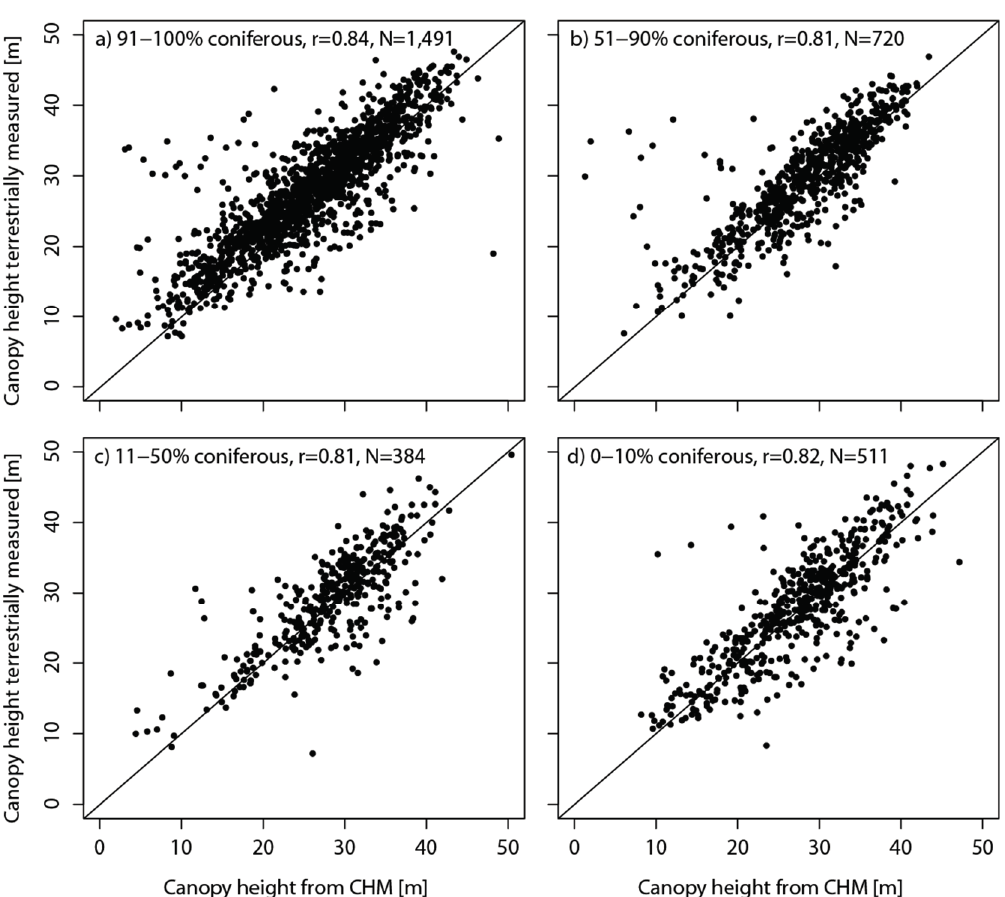
Figure A3. Comparison of canopy height of the CHM with terrestrially measured canopy height at the sample plot level of the NFI. One of the four species mixture classes ( a–d ) depending on the percentage of intermixed coniferous trees was assigned to each sample